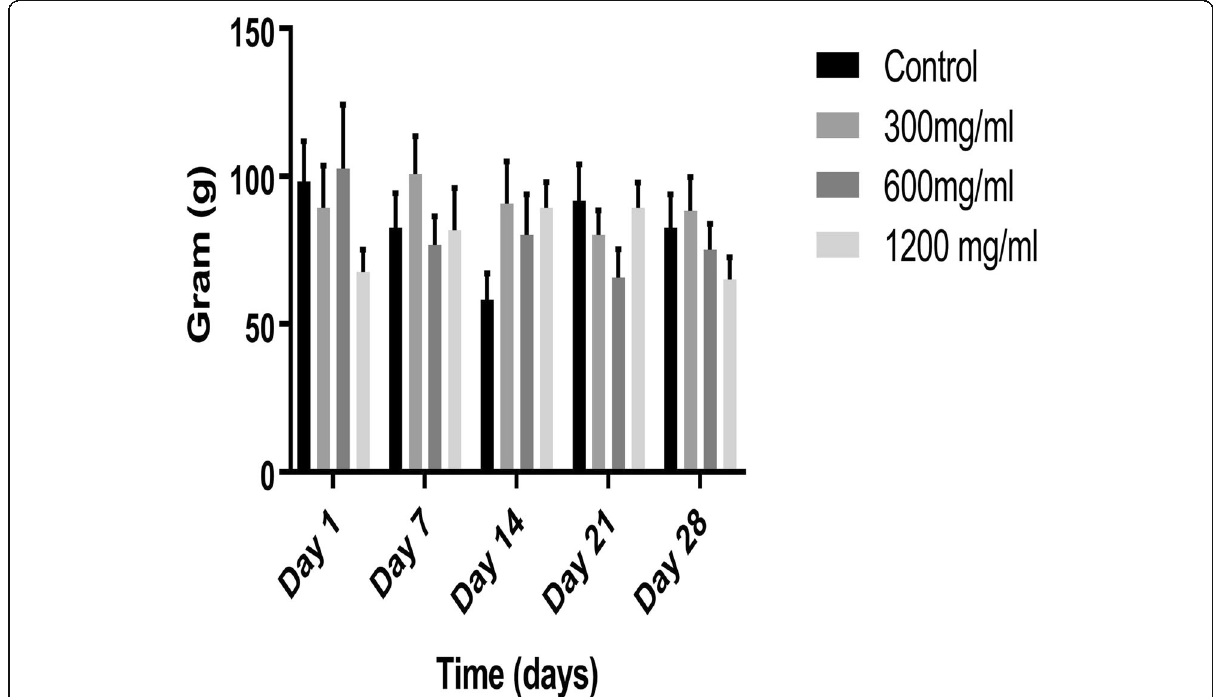
Fig. 7 Effect of STRE on water intake of male subjects. Values are expressed as mean ± SEM Statistical significance (p) calculated by one way ANOVA followed by dunnett ’ s ( n =